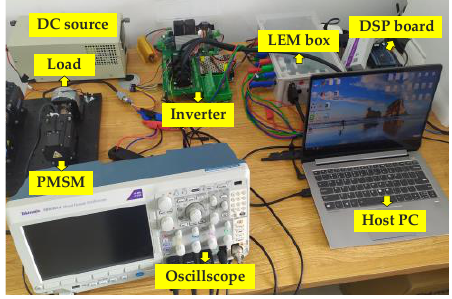
Figure 3. Block diagram of the proposed cascade-free MPDSC for PMSM drives.